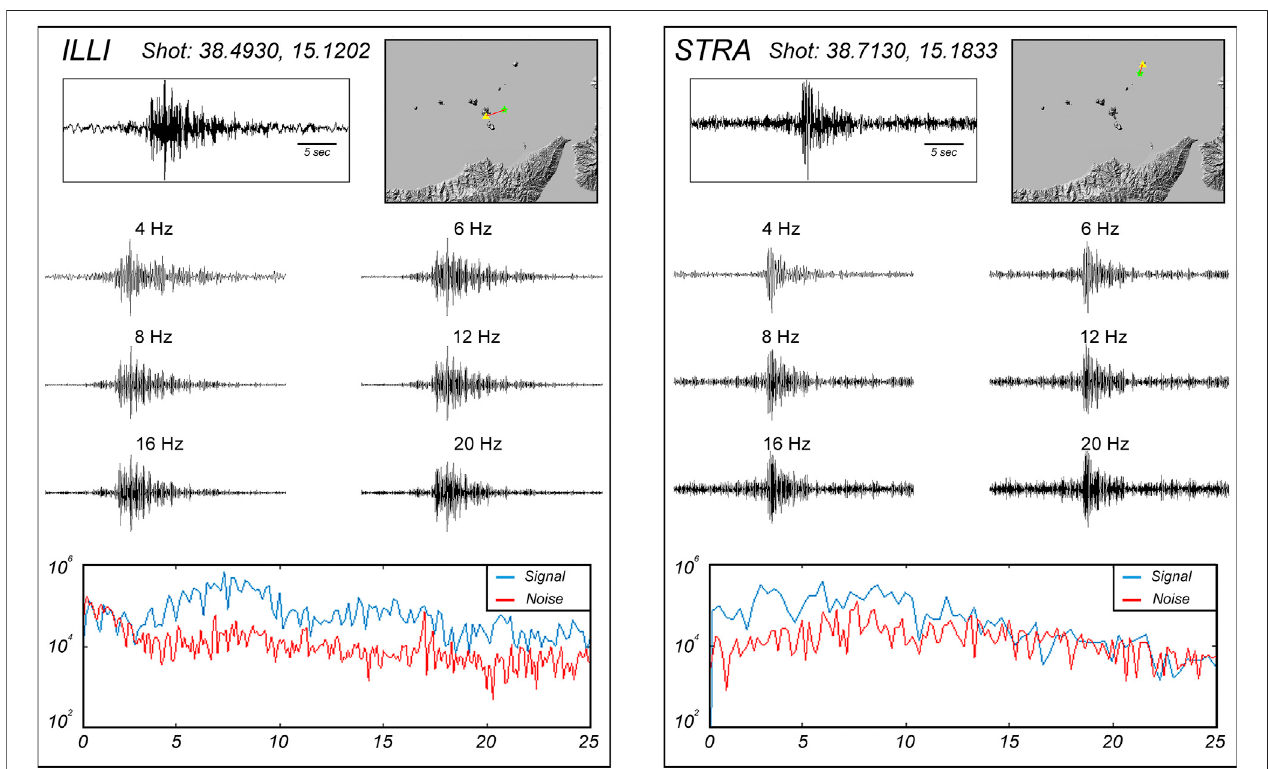
FIGURE 2 | Example seismograms recorded on Lipari and Stromboli islands. Signals were fi ltered in six selected frequency bands. The bottom plots show the spectraofthesignaland pre-eventnoise,whichre fl ectthequalityofthesignals.Seismicstations andshotsareidenti fi edin Figure1 .Theshotrecordedatstation ILLIis that depicted in Figure 3